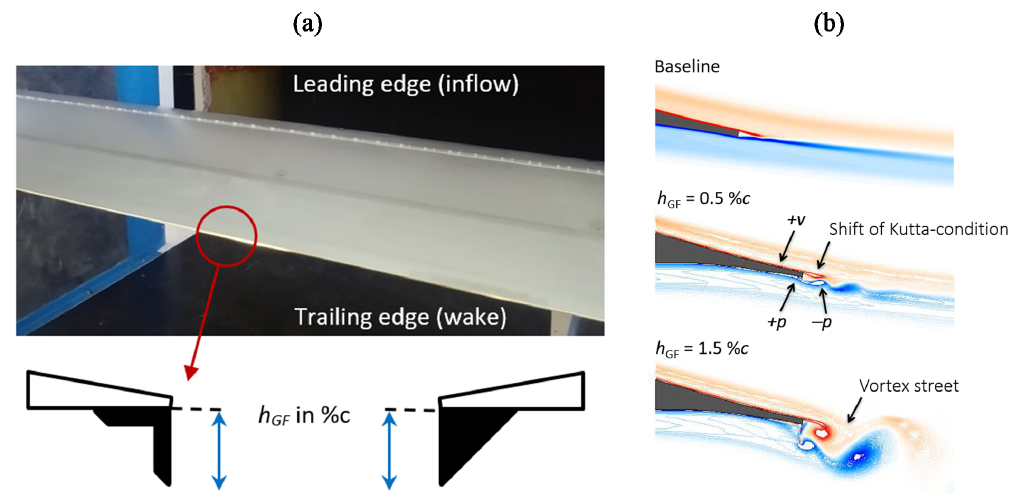
Figure 1. (a) NACA63(3)618 during wind tunnel tests. Vortex generator array and Gurney flap. Definition of Gurney flap height of rectangu- lar and triangular profiles in side view. (b) CFD simulations of the HQ17. Wake structures at α = 0 ◦ and Re = 1 × 10 6 for different Gurney flap heights (reproduced and modified from Schatz et al.